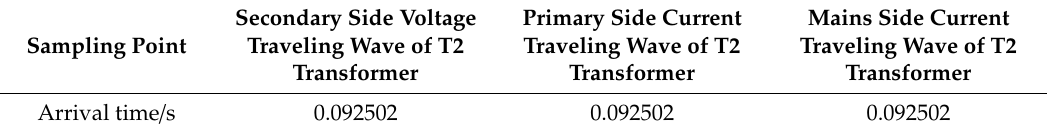
Table 1. Arrival time of the traveling wave at different measuring points.